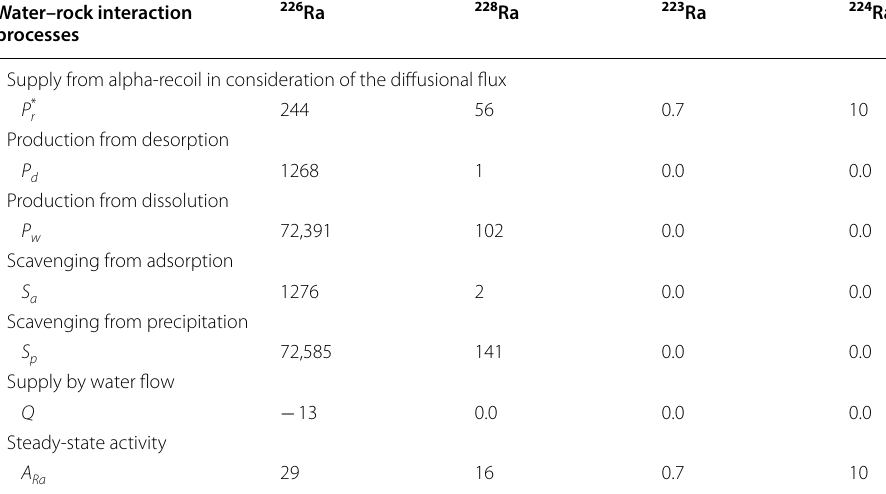
Table 13 Model-derived production and scavenging rates (atoms kg − 1 s − 1 ) for radium in the Bruchsal geothermal system Water–rock interaction